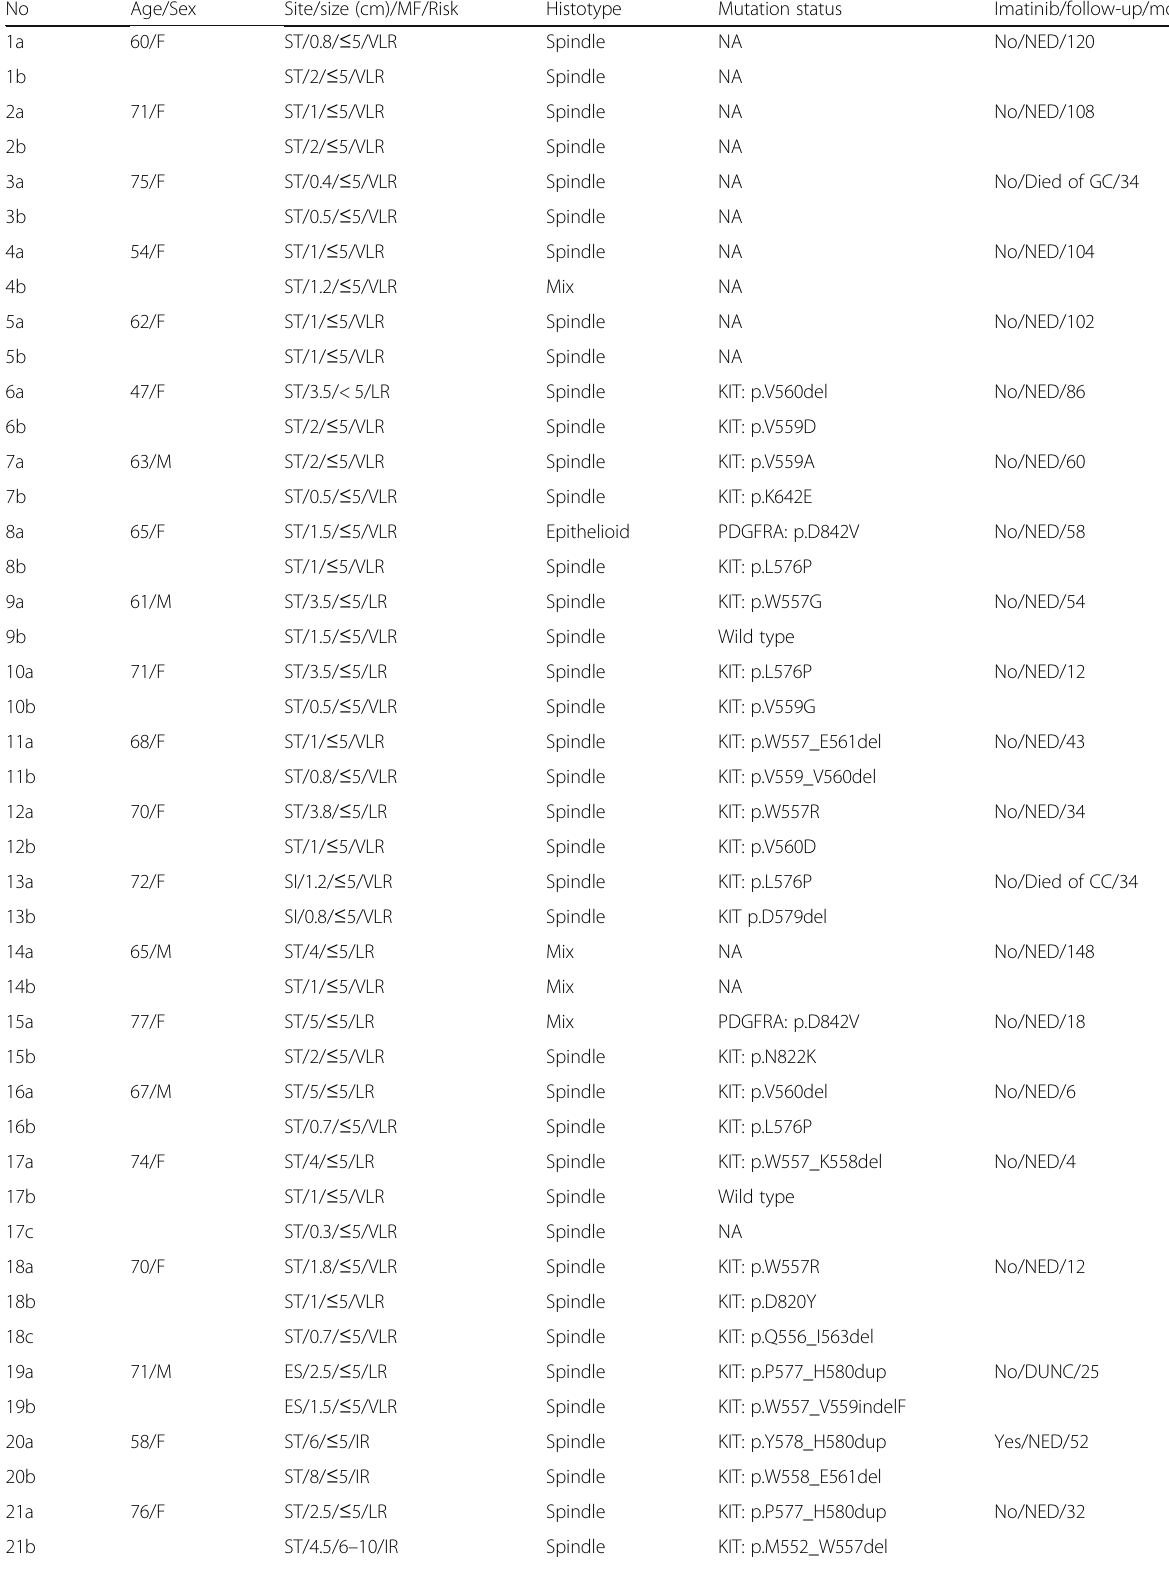
Table 1 Clinicopathologic and molecular features of 27 patients with multiple sporadic